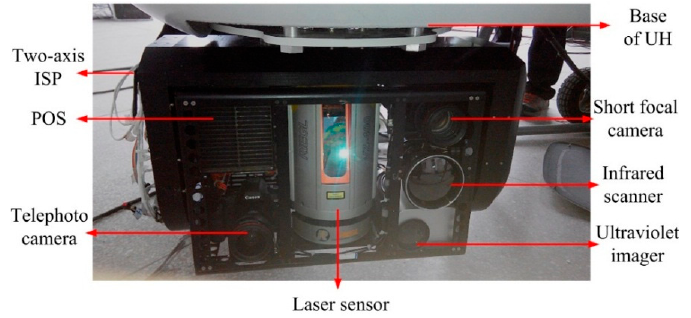
Figure 12. A picture of the two-axis ISP with multiple sensors under the static base testing conditions.